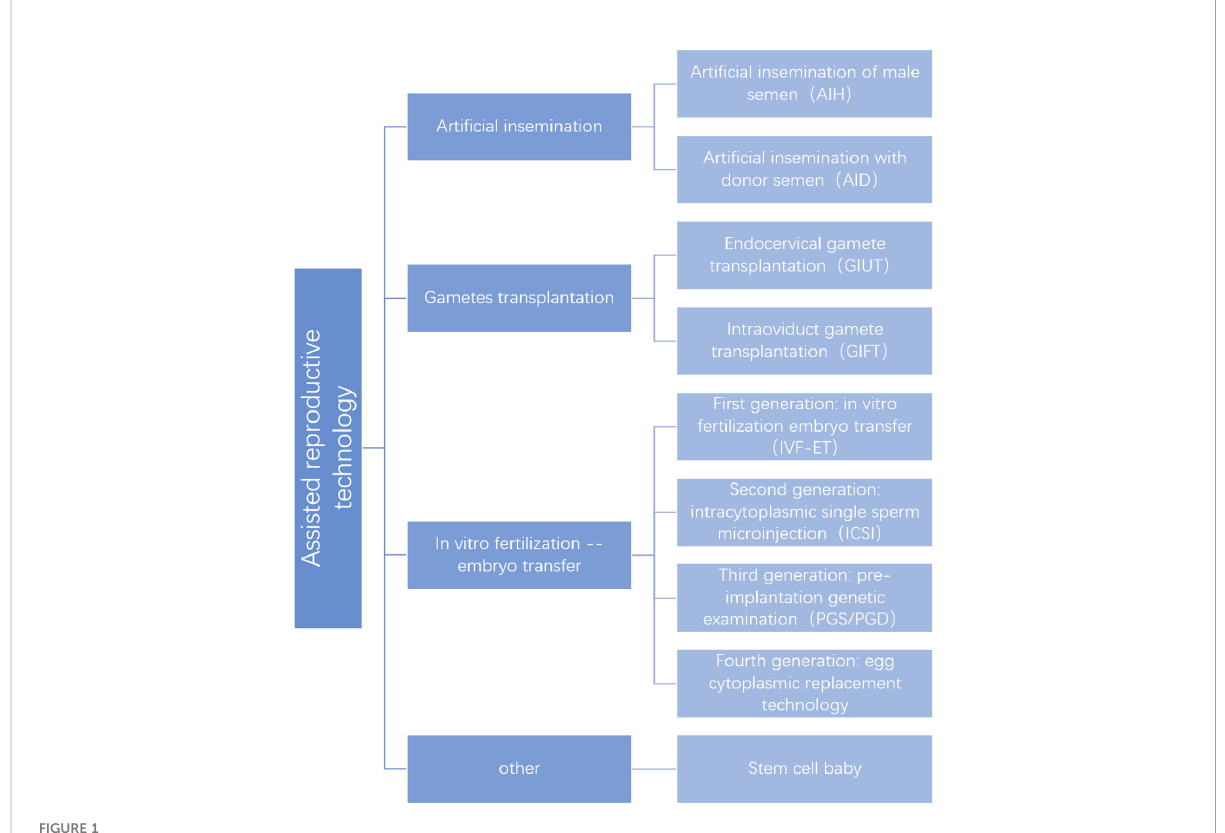
FIGURE 1 Assisted reproduction technology classi fi